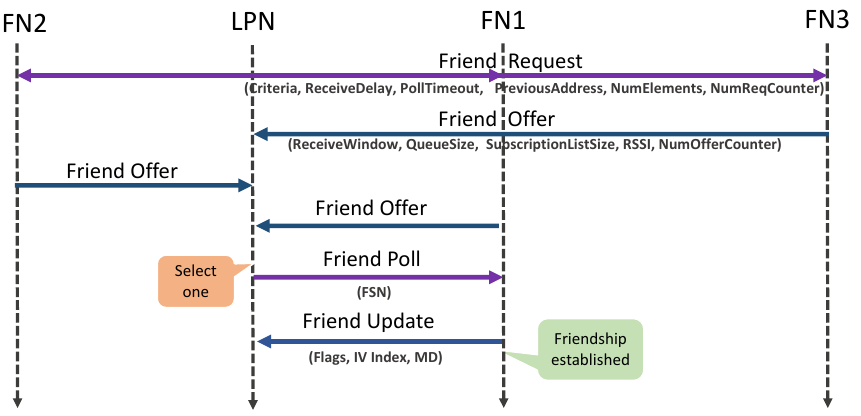
Figure 2. Friendship establishment procedure of